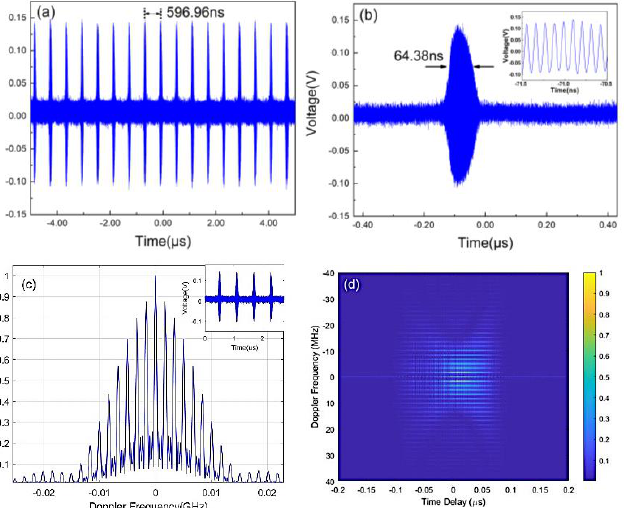
Figure 4. Generated microwave pulses based on fundamental mode-locking: ( a ) temporal waveform, ( b ) enlarged view of the spectrum in ( a ), ( c ) velocity ambiguity function, ( d ) ambiguity diagram. Figure 5a,b show the generated microwave pulses with a central frequency of 5.47 GHz